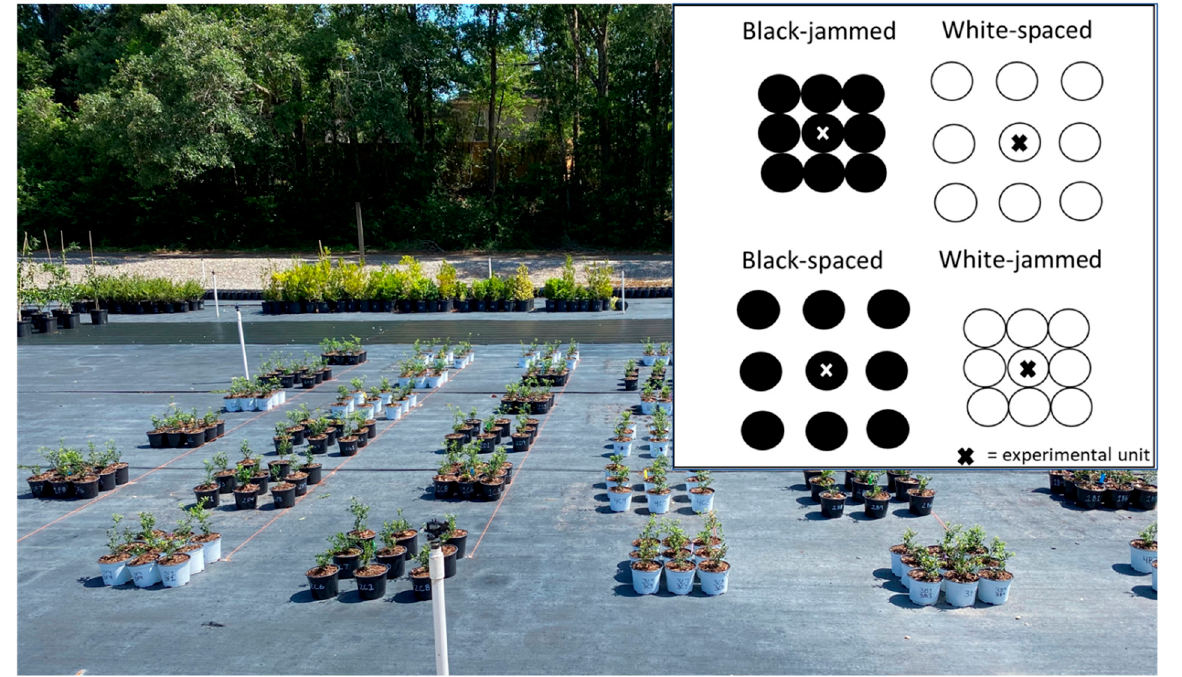
Figure 1. Experimental layout of fixed effect combinations, representing one block.